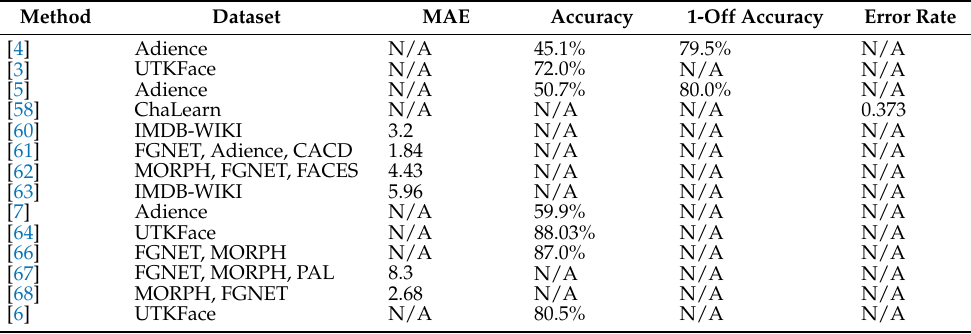
Table 4. Comparison of different proposed age estimation